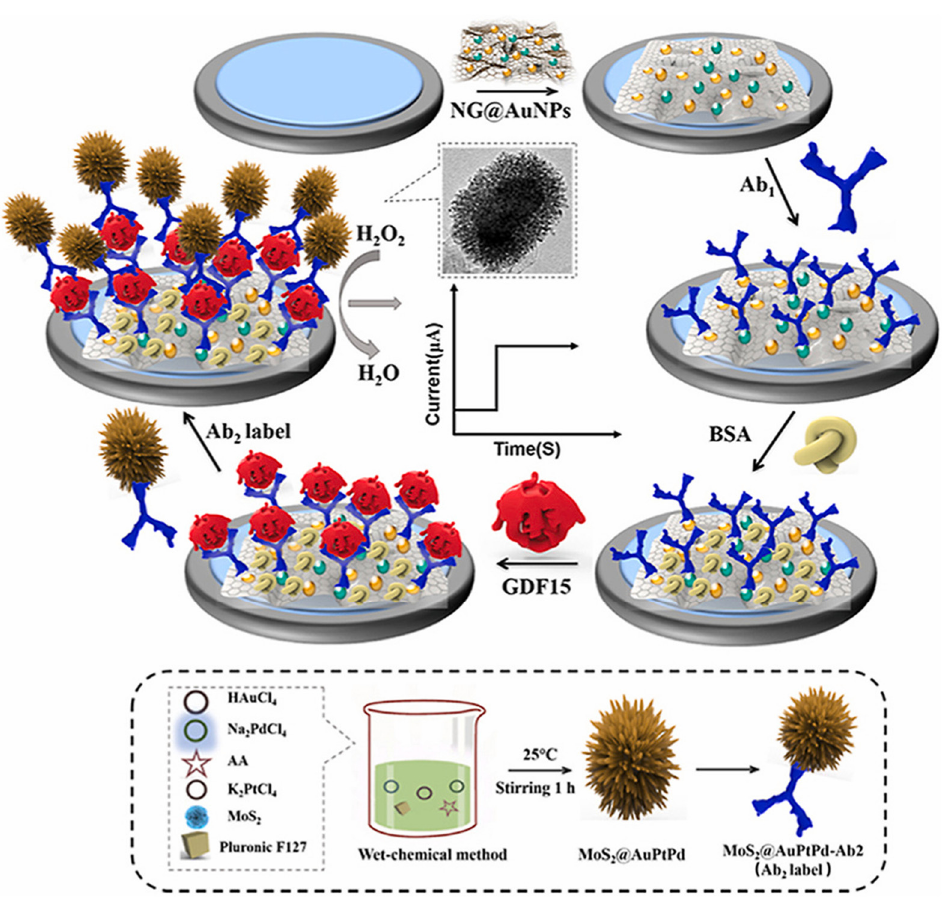
Figure 13. Schematic illustration for the development of a sandwich-type electrochemical sensor for GDF-15 detection sensor. Reprinted with permission from Ref. [79] . Copyright 2022,